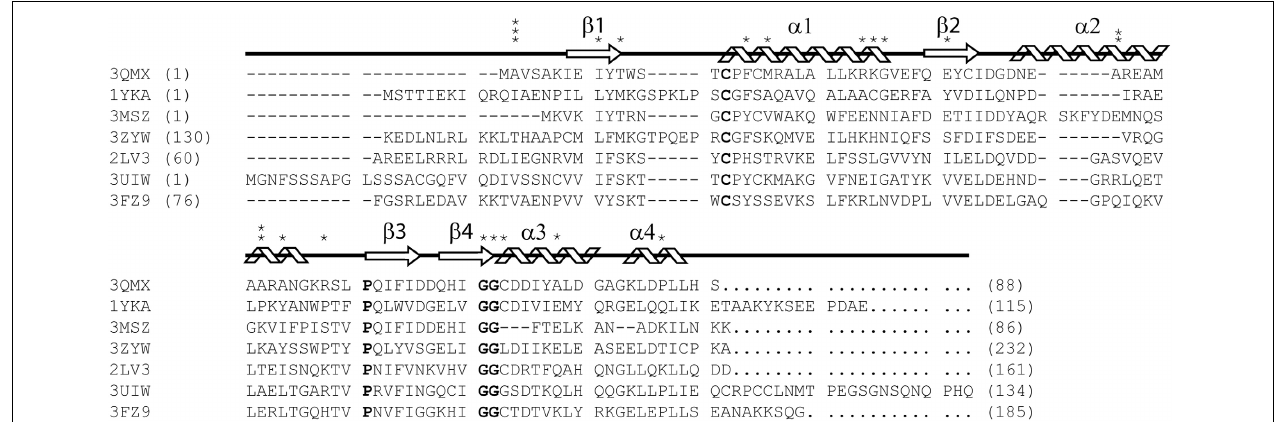
FIGURE 1 | ClustalX primary sequence alignment of Synechocystis sp. PCC 6803 glutaredoxin A (3QMX) Kim et al., 2012, Grx4 from E. coli (1YKA) (Fladvad et al., 2005), Grx1 from Francisella tularensis (3MSZ), glutaredoxin domain from human glutaredoxin 3 (3ZYW), Grx domain from Mus thioredoxin reductase (2LV3) (Dobrovolska et al., 2012), Zebrafish Grx2 (3UIW) (Brautigam et al., 2013), glutaredoxin S12 from Poplar (3FZ9) (Couturier et al., 2009). were excluded from this alignment.